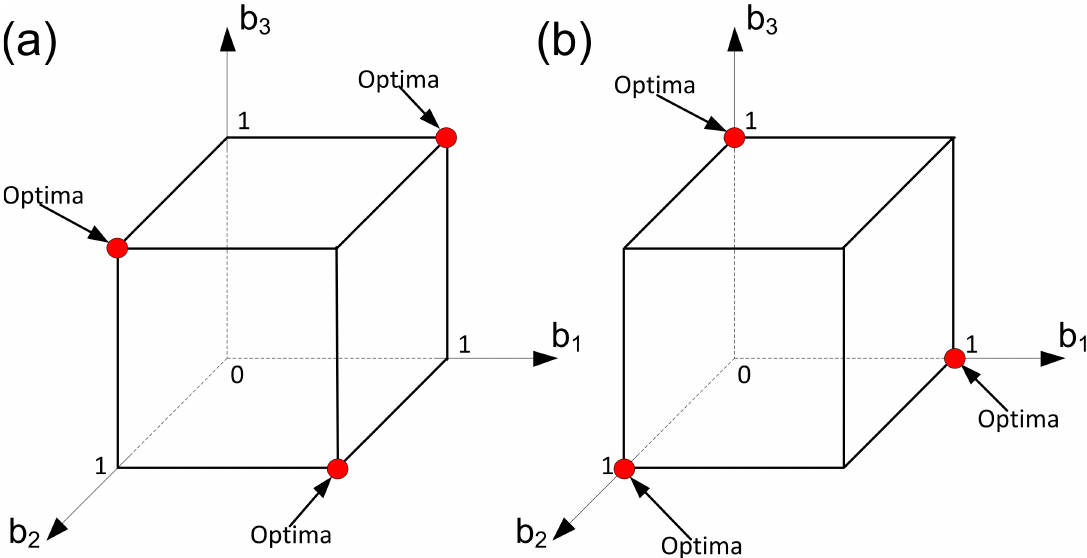
Fig 1. Evolution of germ and soma in colonies with identical cells: A convex trade-off, a resource constraint and different ‘importances’ of viability and fecundity (Case 1). Here we assume that we have three groups of cells within the colony such that all cells from each group have the same level of fecundity and the same level of viability (i.e., we have three ‘aggregate’ cells in the colony). Optimal strategies of the colony are colored in red. The level of specialization in soma and germ depends on the relative ‘importance’ of fecundity to viability. In both panels, k 1 = k 2 = 1, α = 1, C = 4 and φ = ( b- 1) 2 . In panel (a), β = 0.5. In panel (b), β = 2.